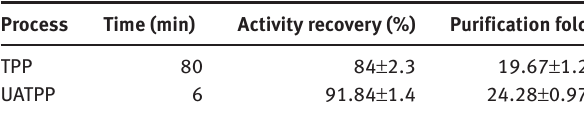
Table 1: Comparison of conventional three phase partitioning (TPP) and ultrasound assisted three phase partitioning (UATPP).